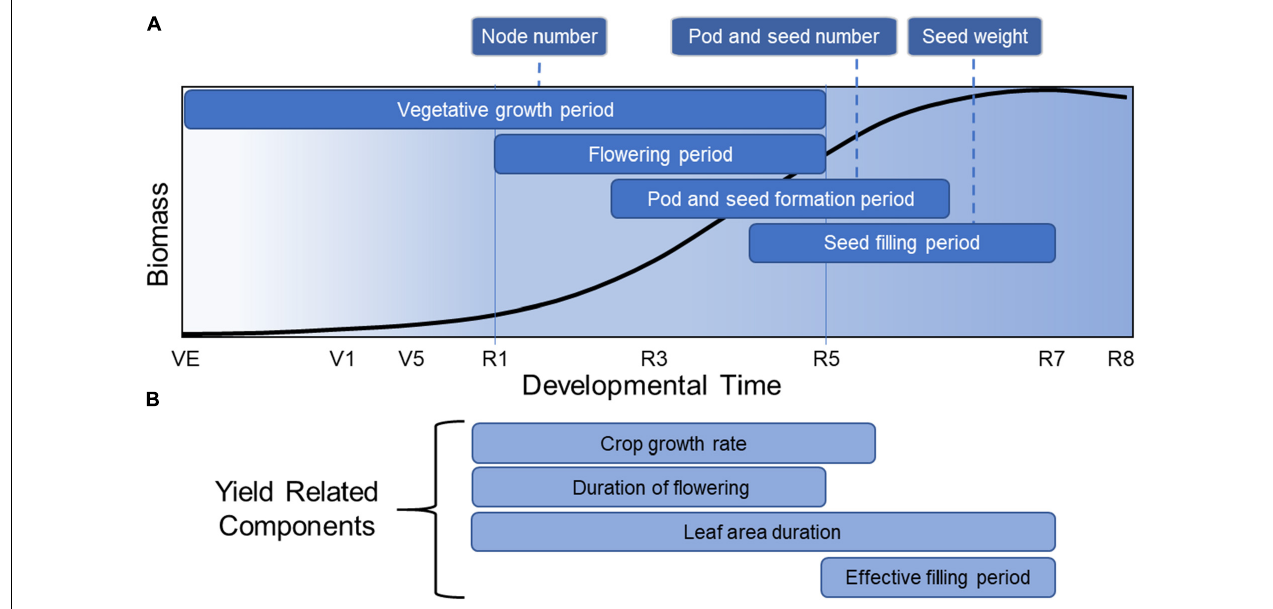
FIGURE 2 | Total soybean biomass accumulation over developmental time overlain with the critical periods for yield formation. This figure represents the general accumulation of soybean biomass accumulated in all parts of the plant over developmental time, adapted from data described by Pederson and Licht (2014). (A) Critical periods for node, pod, seed number and seed weight are indicated. (B) Yield-related components are indicated during the developmental times at which they are most relevant for yield